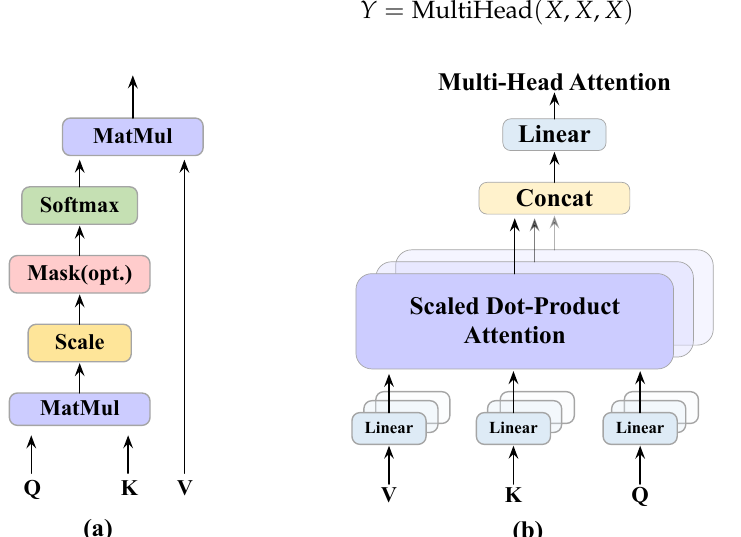
Figure 8. ( a ) The attention mechanism. ( b ) The abstract computational flow of the multi-headed attention